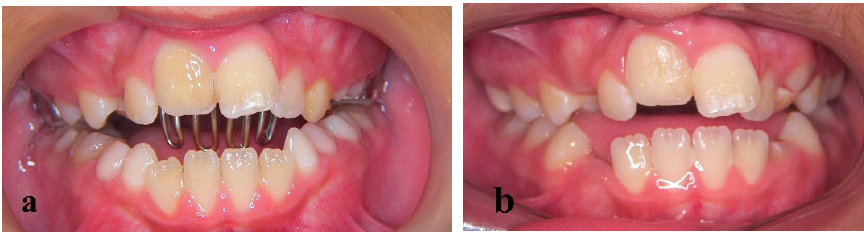
Figure 3. Functional treatment by a tongue crib. ( a ) Tongue crib appliance in place, ( b ) improvement in the open bite and first sign of ankylosis of right central incisor.